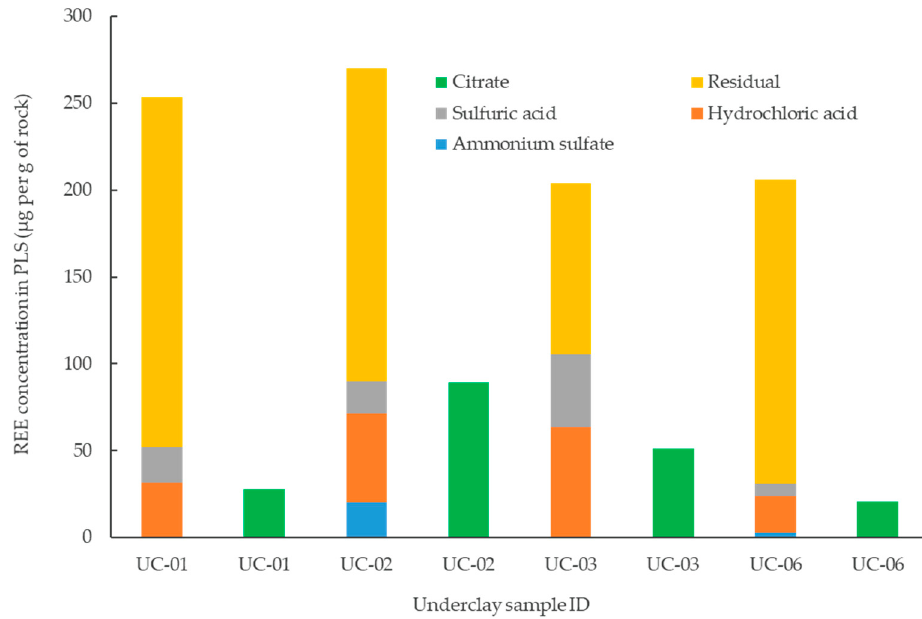
Figure 3. Concentration of REE in PLS after leaching with citrate solution and sequential digestion solutions. Concentrations leached into PLS for each step are denoted by the different bar colors. Citrate recovery values are shown as green bars. Values are reported as concentration of element in leached into PLS per gram of material (µg/g).